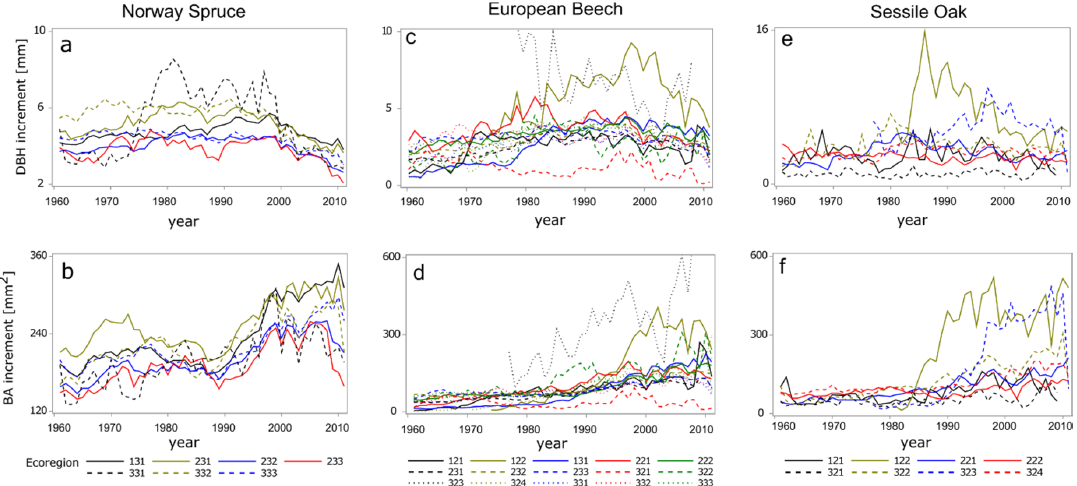
Figure 3. DBH increment and basal area increment mean by ecoregion for Norway spruce ( a , b ), European beech ( c , d ) and Sessile oak ( e , f ) over time. Table 3. Estimates and standard errors (in parenthesis) for DBH increment (DBHi) and basal area increment (BAi) for Norway spruce, European beech and Sessile oak by ecoregion.